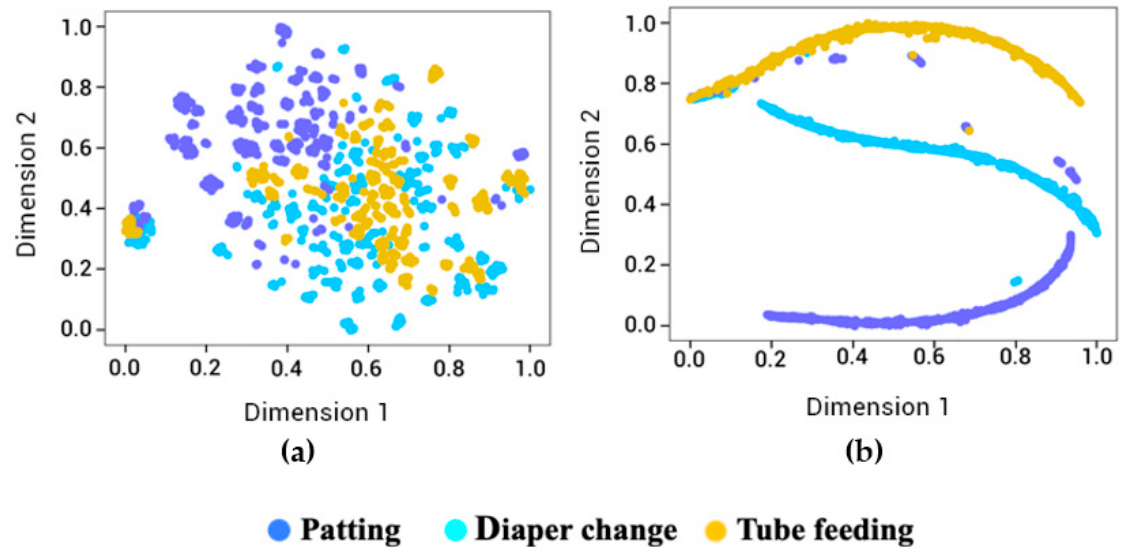
Figure 5. t-Distributed Stochastic Neighbor Embedding (t-SNE) visualization for the manipulations (patting, diaper change, and tube feeding) ( a ) without transfer learning and ( b ) with transfer learning. Perplexity is 35, and the number of iterations is 20000.